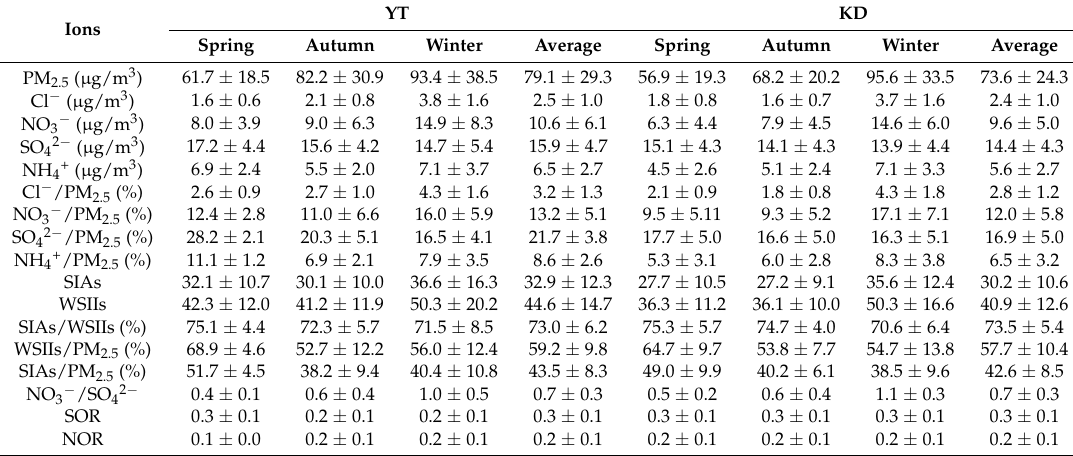
Table 2. Major water-soluble ion concentrations ( µ g/m 3 ) and the corresponding contribution to PM 2.5 (%), sulphur oxidation ratio (SOR), and nitrogen oxidation ratio (NOR) in PM 2.5 at the YT and KD sites. YT KD Ions Spring